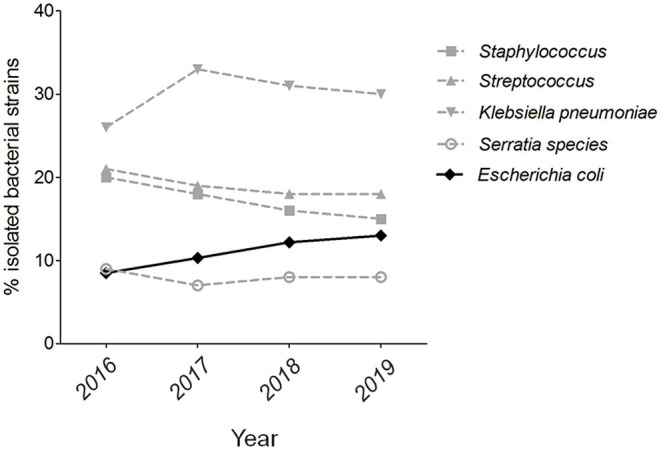
The isolation rate of E. coli strains on bovine mastitis in China. The isolation rates of five mainly pathogenic species in bovine mastitis from 2016 to 2019.